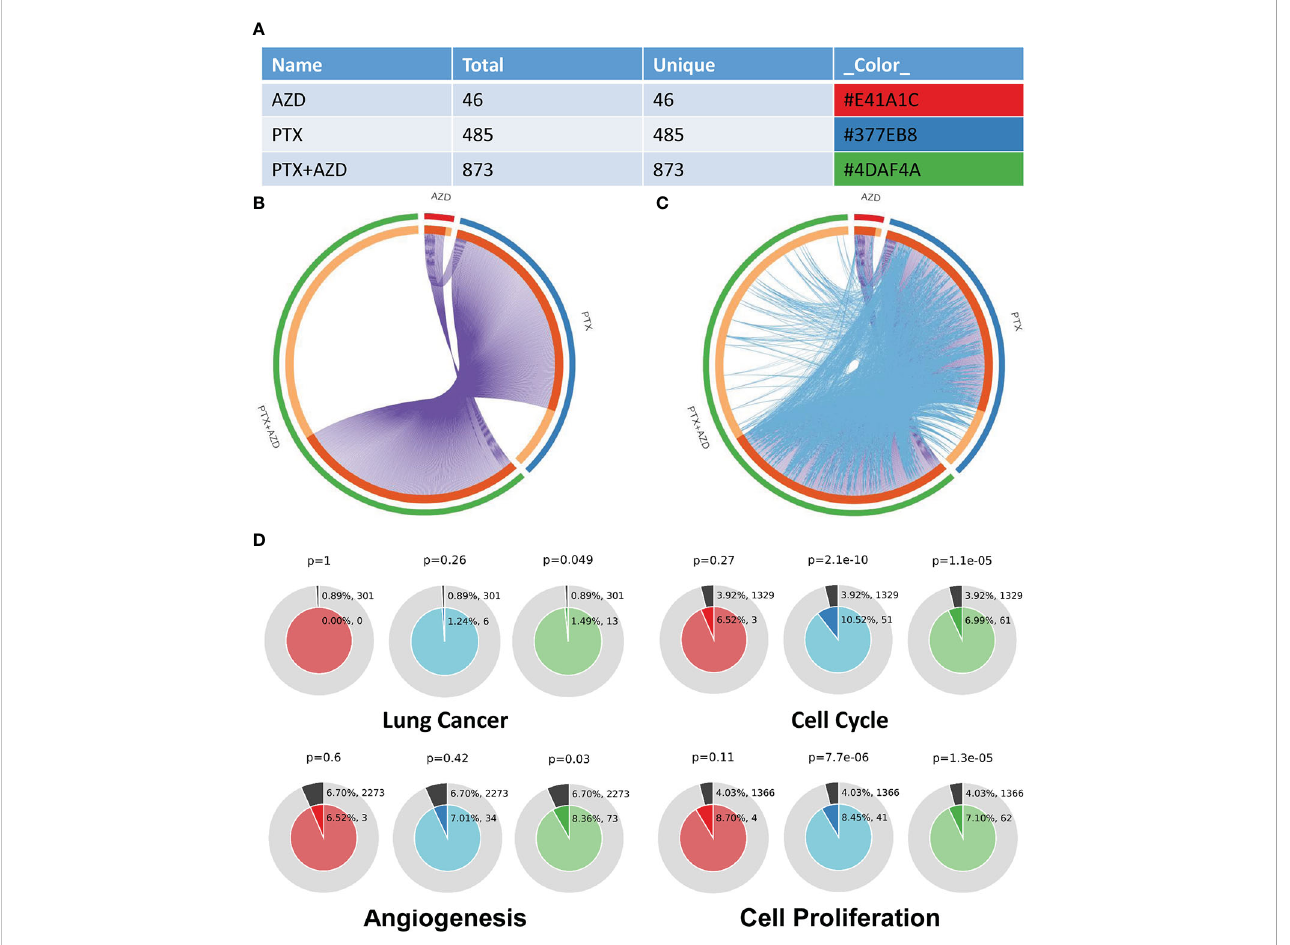
FIGURE 4 Gene annotation and membership search. (A) Gene List Summary. (B, C) Gene overlap analysis expanded via shared enriched ontologies. (D) Membership analysis: pie chart for visualization of membership enrichment (the outer pie shows the number and percentage of genes in the background associated with the membership (in black); the inner pie shows the number and percentage of genes in the individual input gene list associated with the